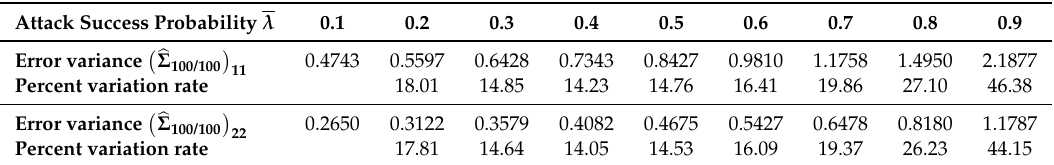
Table 1. Distributed filtering error variances at k = 100 and percent variation rates of the first and second signal components under different attack success probabilities λ